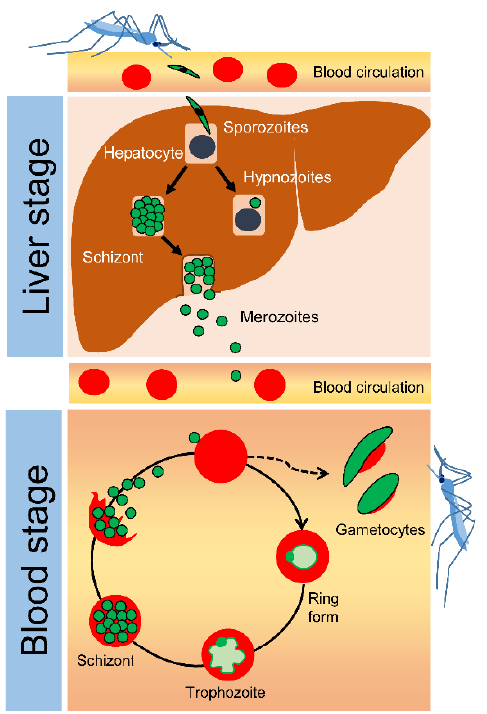
Figure 1. Development of Plasmodium parasites in the human body [7]. During blood feeding, a female mosquito secretes anti-blood clotting factors from the salivary gland, from which sporozoites are collaterally released into the bloodstream. Upon inoculation through the dermis, sporozoites eventually invade the liver, the first location of Plasmodium infection in humans. In the invaded liver, sporozoites enter hepatocytes and undergo asexual multiplication (schizogony), resulting in a merozoite-harboring hepatocyte known as a liver schizont. After approximately one week, the hepatic schizonts burst, and thousands of merozoites enter the bloodstream. For P. vivax and P. ovale , some merozoites undergo a stage of inactive proliferation (dormancy), known as hypnozoites, which cause relapse months or years later. Hepatocyte-derived merozoites invade erythrocytes and begin a repeated cycle of asexual, intraerythrocytic development involving ring-formed trophozoites, trophozoites, and schizonts. Rupture of schizonts causes periodic fever and, for some Plasmodium species, possibly leads to severe, lethal symptoms, such as anemia, multiorgan failure and cerebral malaria. Some host erythrocytes develop into sex cells, termed gametocytes. Female Anopheles mosquitoes take up gametocytes during a blood meal. In the mosquito gut, fertilization of gametocytes results in the production of sporozoites, which specifically migrate to the salivary glands of Anopheles mosquitoes to await inoculation at the next blood feed.